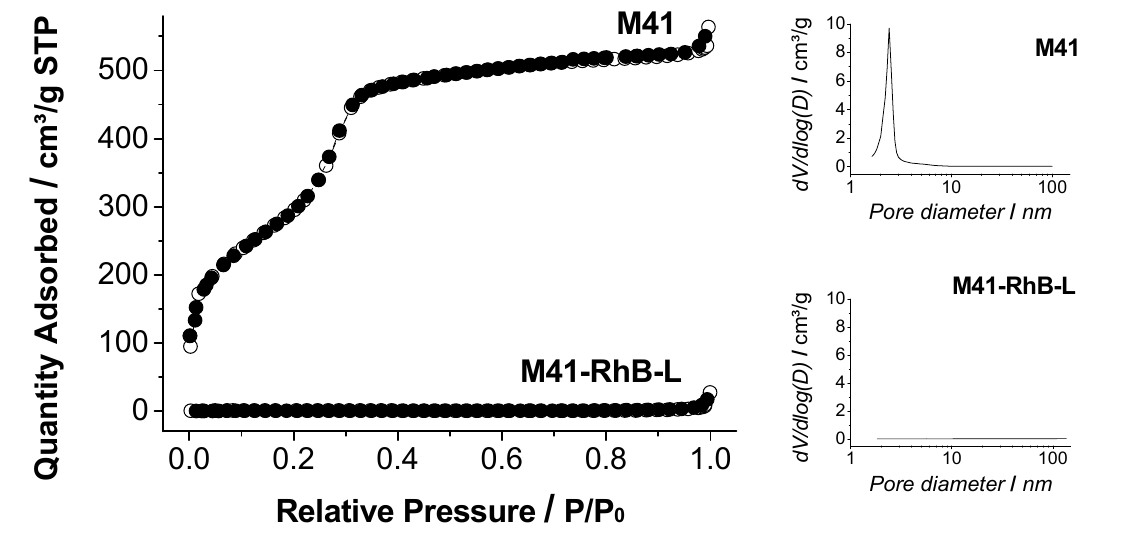
Figure 2. Left: Nitrogen adsorption ( ) desorption ( • ) isotherms of the calcined starting material M41 and M41-RhB-L. (cid:35) Right: pore distribution graphs of M41 ( top ) and M41-RhB-L ( bottom ). Table 1. BET specific surface values, pore volumes and pore sizes calculated from the N 2 adsorption- desorption isotherms for bare and final-model